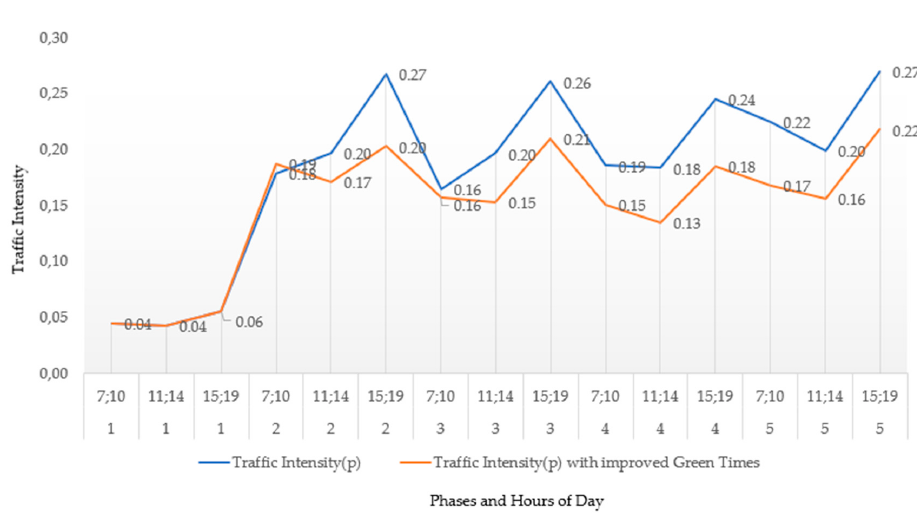
Figure 12. Density comparison of phases with improved green times.